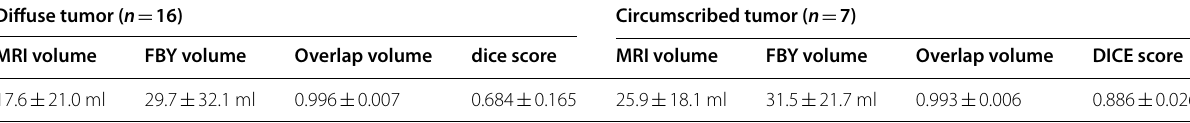
Table 2 Volume of MRI-based segmentation and FBY-based segmentation in contrast-enhanced brain tumor Diffuse tumor ( n =